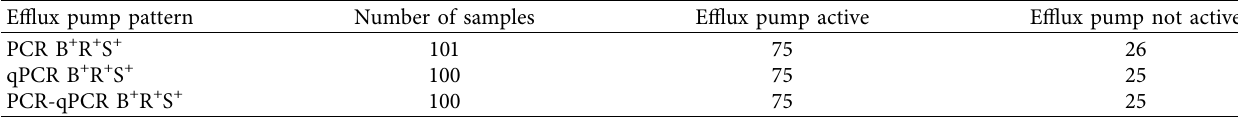
Figure 1: Antimicrobial susceptibility testing. Table 1: Combined analysis of molecular and phenotypic investigations of the active efflux pump.